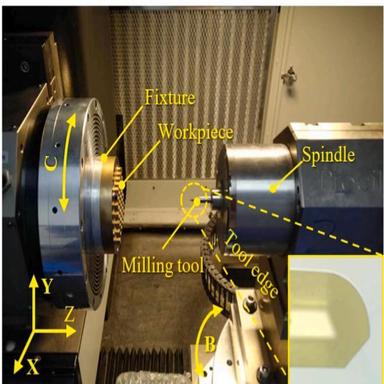
UPDM experiments.